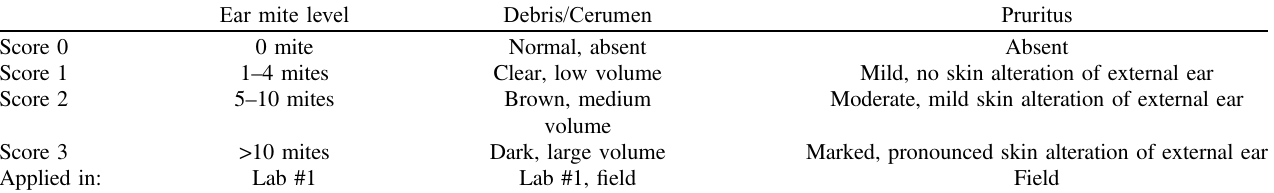
Table 2. Otoscopical and clinical scoring.